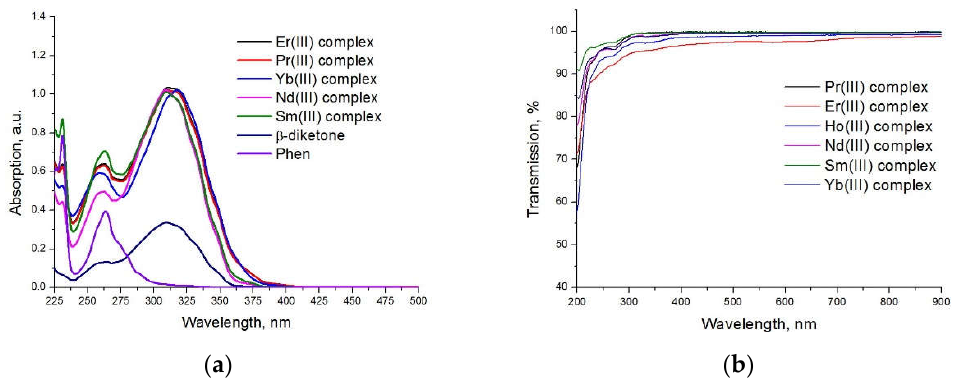
Figure 2. ( a ) Absorption spectra of lanthanide(III) complexes and ligands dissolved in hexane with the concentration of 10 −5 mol/L; ( b ) transmittance spectra of the films containing lanthanide(III) complexes. To determine the energy levels of the ligand environment, we studied the luminescent properties of the gadolinium Gd(III) complexes that were incorporated into thin films by spin coating at the temperature of liquid nitrogen (T = 77 K) (Figure 3). A Gd 3+ ion does